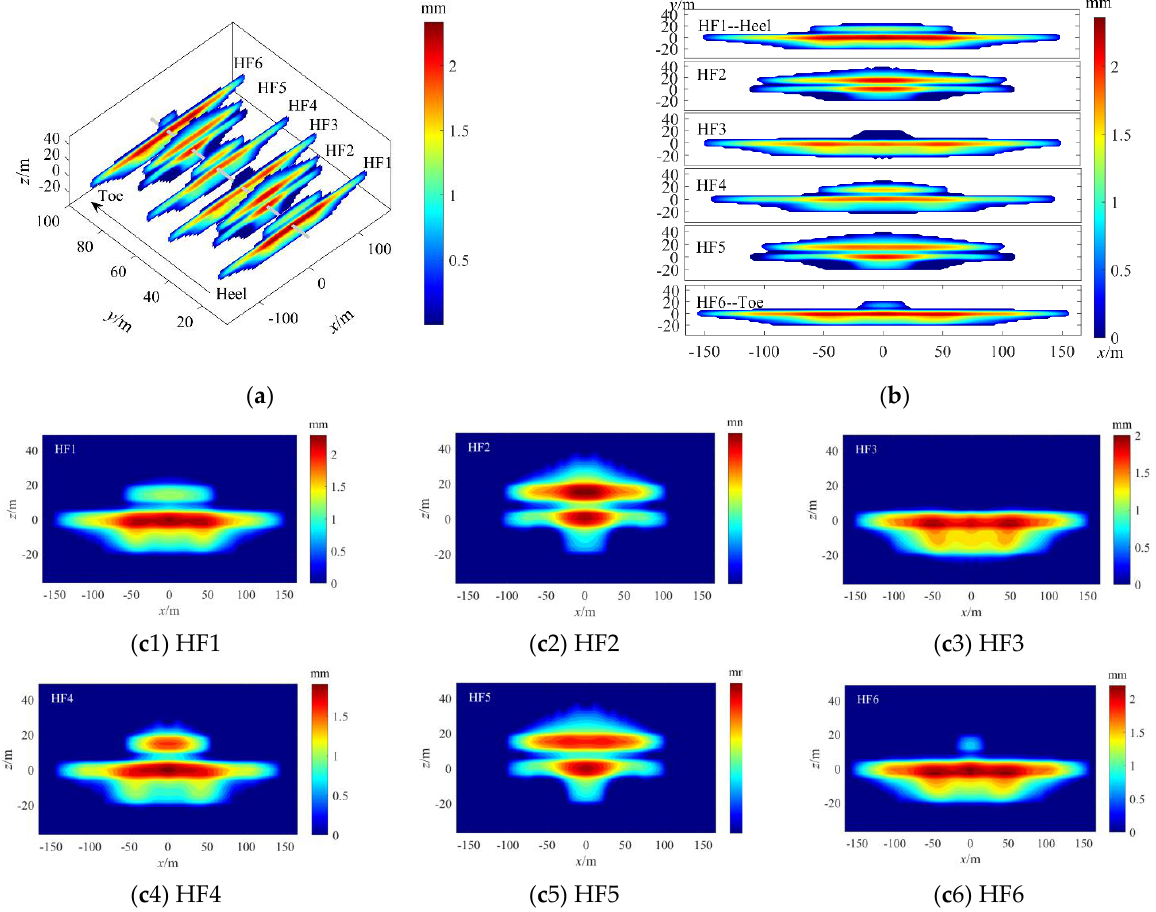
Figure 4. Patterns of fractures in the base case group: ( a ) is a three−dimensional view; ( b ) is an overall comparison of the six fractures; ( c ) shows the width and profile of each fracture. The variation coefficient of fluid allocation is defined as